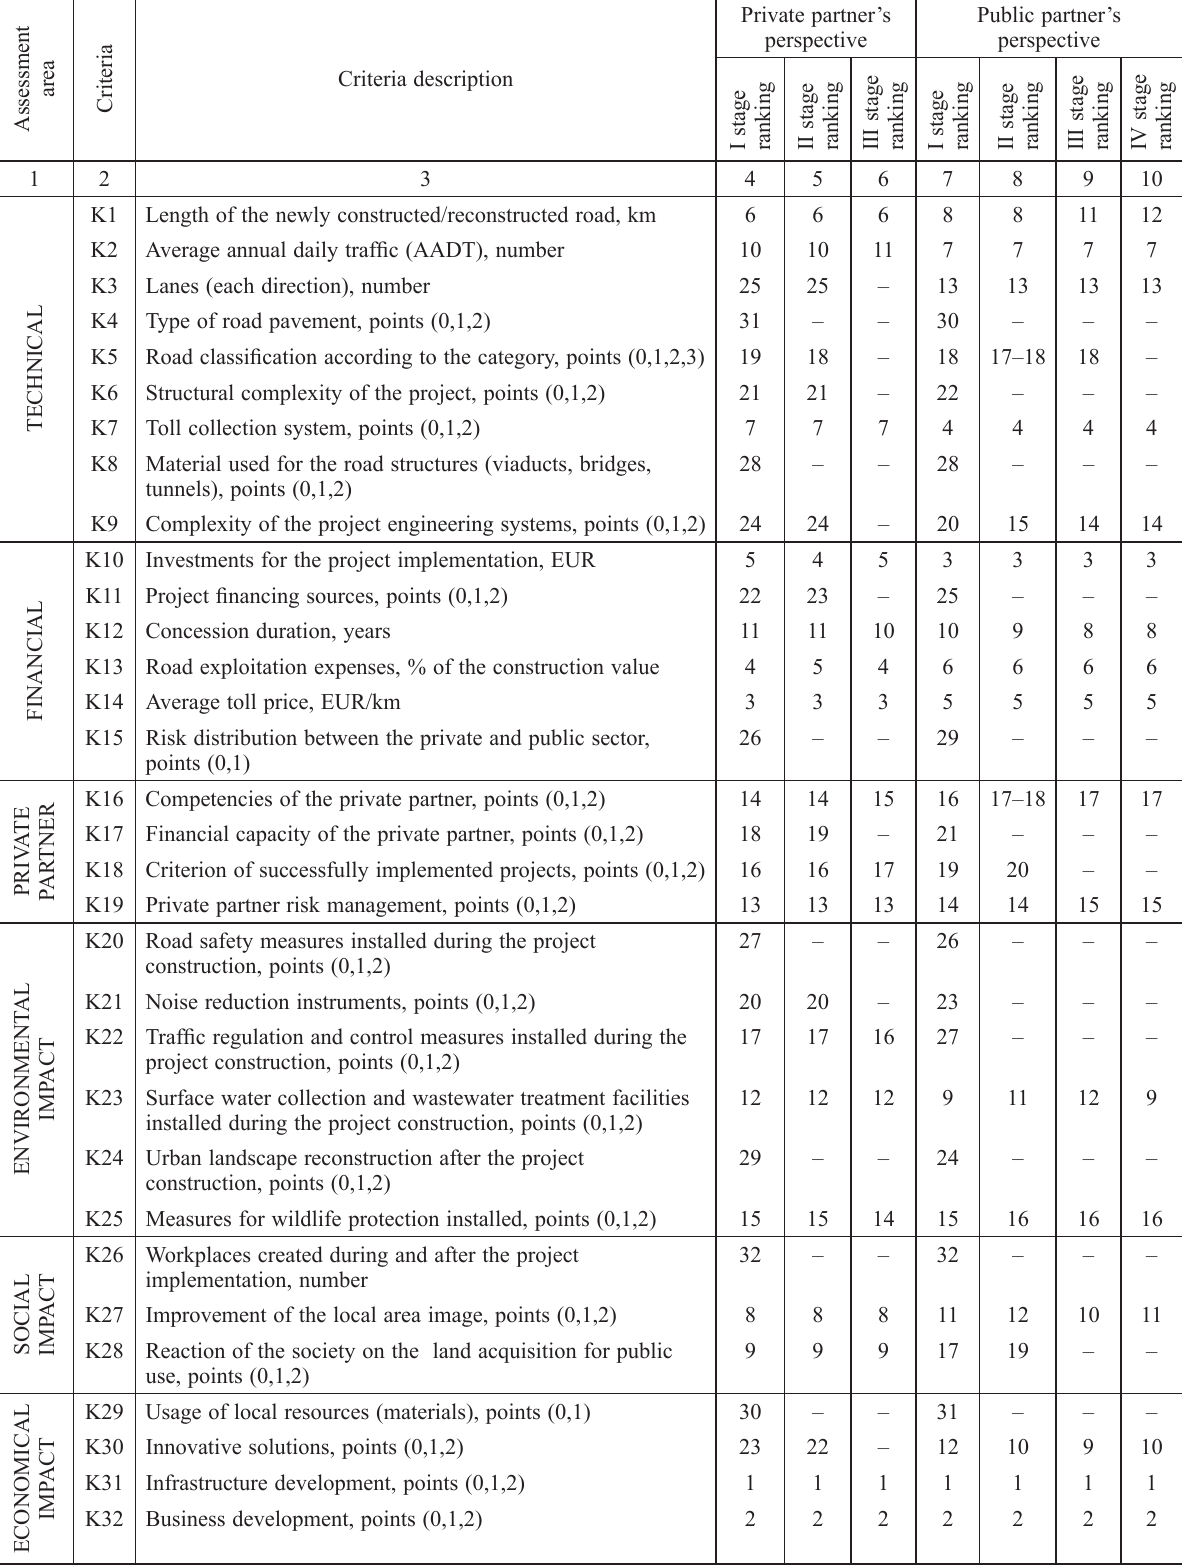
Table 2. Quantitative and qualitative assessment